Question: Briefly state, in one sentence, what is plotted here.
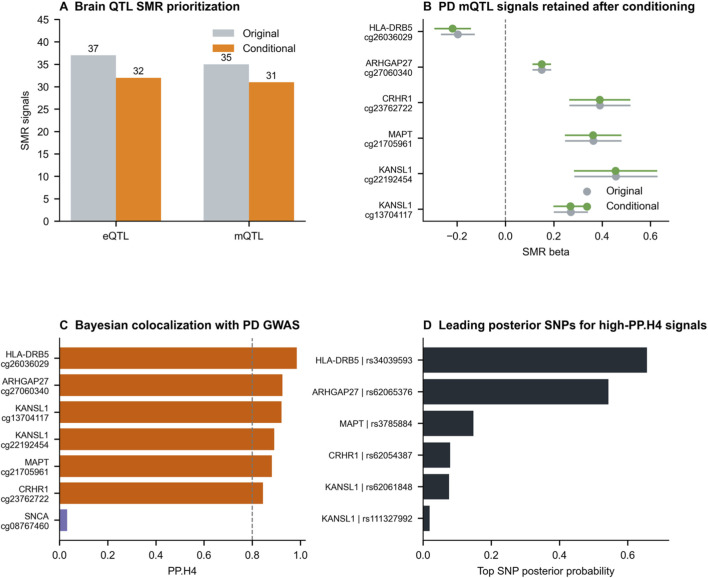
Answer: Brain QTL prioritization and Bayesian colocalization. (A) Counts of significant brain eQTL and mQTL SMR signals before and after conditioning. (B) PD mQTL SMR estimates before and after conditioning for retained methylation probes. Points indicate SMR beta estimates and horizontal lines indicate approximate 95% confidence intervals. (C) Posterior probability of a shared PD-GWAS and mQTL signal (PP.H4) from coloc. The dashed line marks PP.H4 = 0.80. (D) Highest SNP-level posterior probability for each high-PP.H4 PD colocalization analysis.